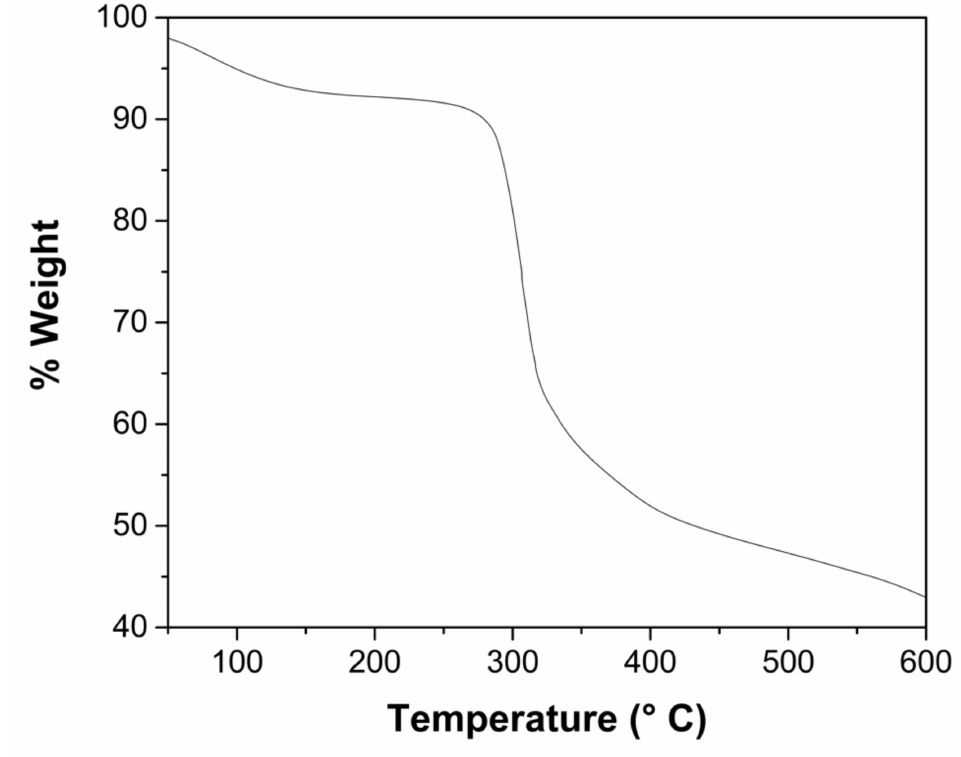
Figure 1. Thermogravimetric analysis of ChM